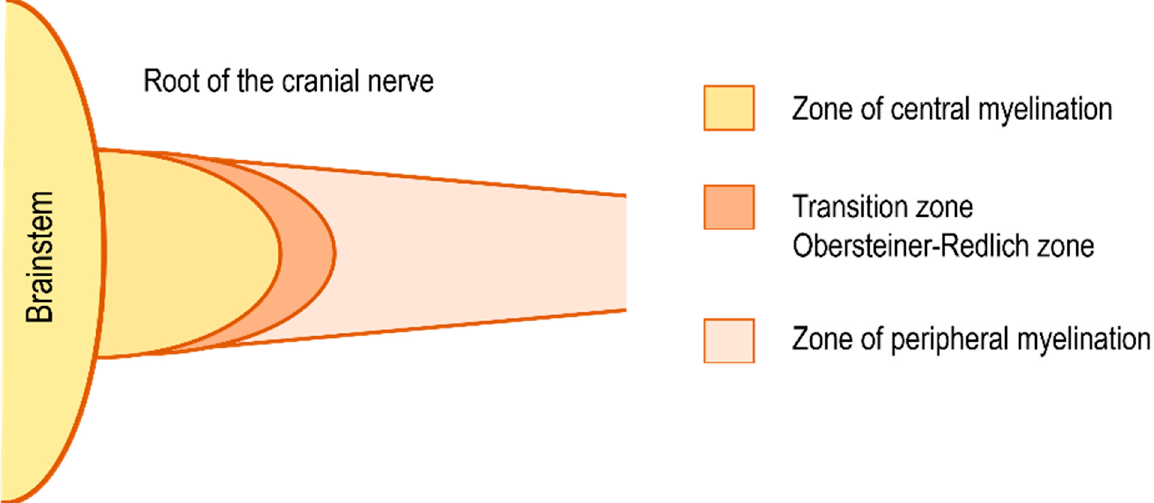
Figure 1. Scheme of the transition zone (Obersteiner–Redlich zone) between the central and peripheral zone of myelination of the cranial nerve. Zone of peripheral myelination lateral, centrifugal, to the transition zone is the site of vestibular schwannoma origin.